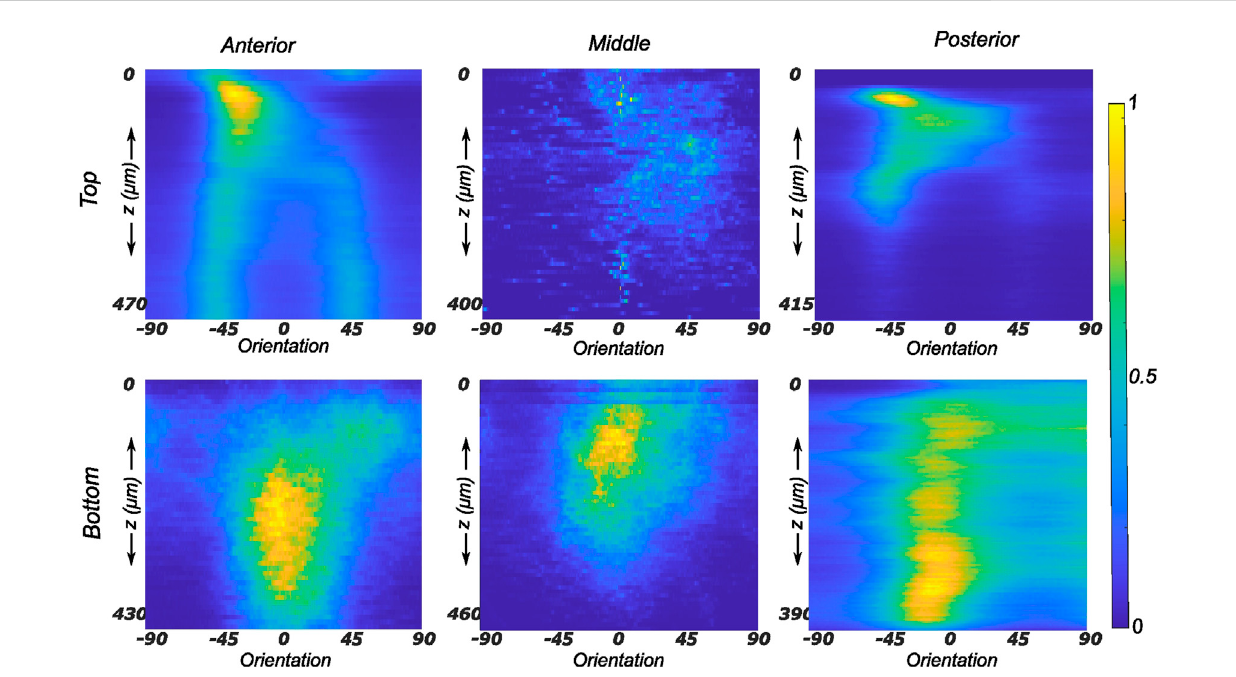
FIGURE 5 Depth pro fi le of collagen fi ber intensity of samples obtained from the lateral meniscus. The images recorded on the entire stack were analyzed individually andcompiled togetherinMatlab toproducean intensity plotrepresentativeofthetransmuralvariation incollagen fi bermorphology. Thetop and bottom rows of subplots represent the top and bottom samples, respectively. Column-wise, they represent the anterior, mid-body, and posterior